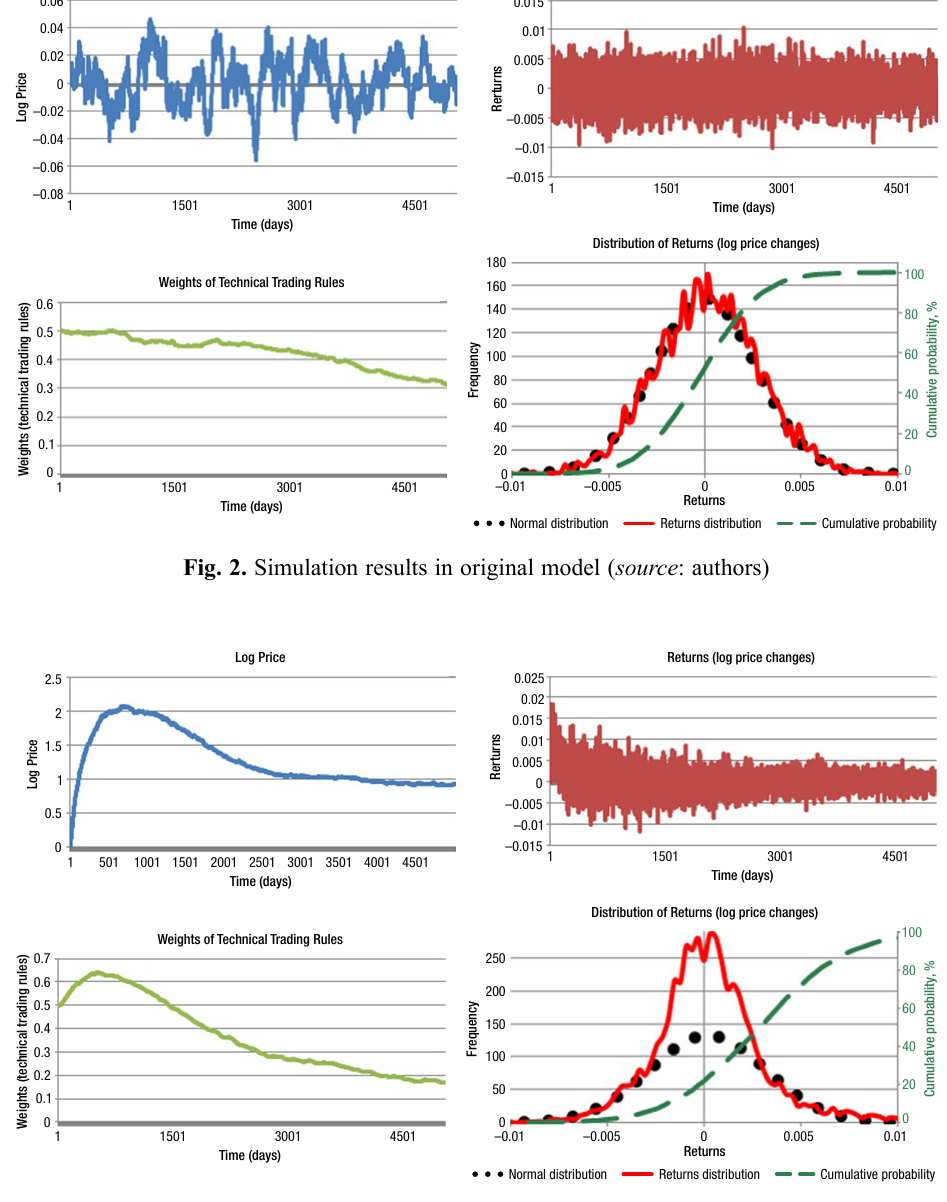
Fig. 3. Simulation results with transaction costs ( source :